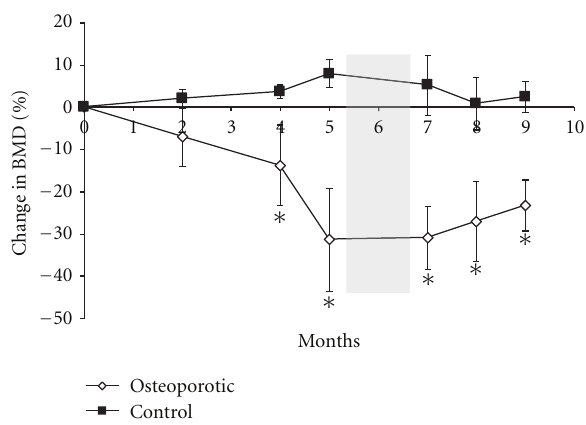
Figure 3: Percentage change in BMD in control and osteoporotic sheep. The highlighted gray area shows the period of corticosteroid withdrawal. BMD of osteoporotic sheep remained lower than controls after withdrawal of corticosteroids ( ∗ P < 0 .